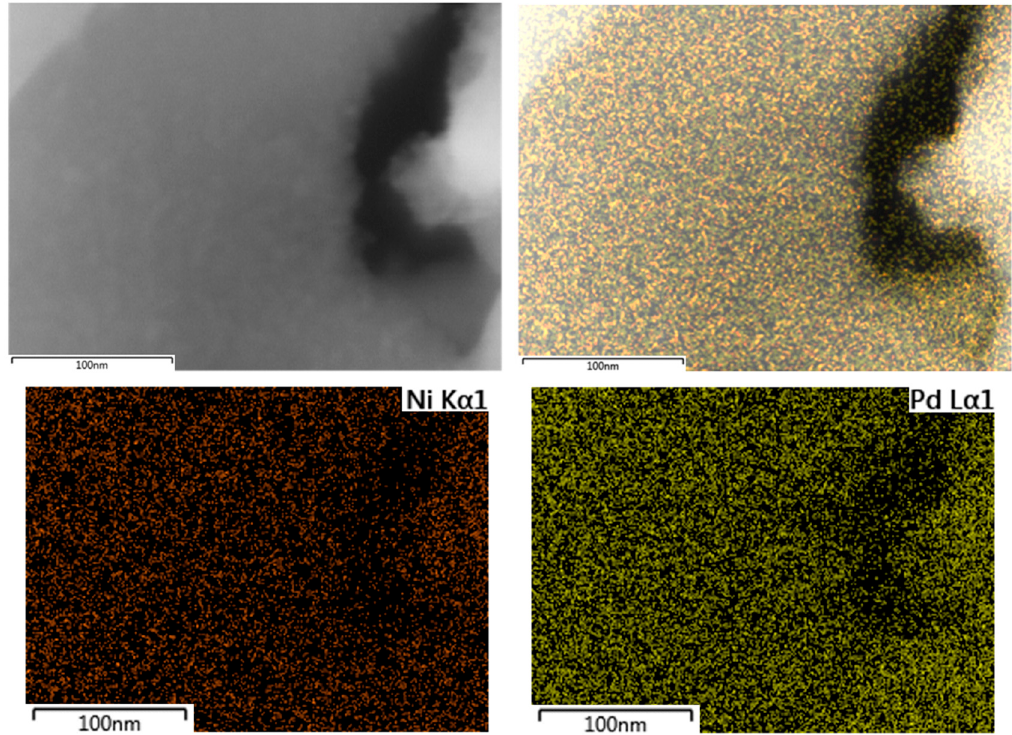
Figure 10. SEM image ( top left ), SEM image with overlay of the palladium and nickel mappings ( top right ), nickel K α 1 EDX mapping ( bottom left ) and palladium L α 1 EDX mapping ( bottom right ) of the PdNi-Ce-LDH-200 catalyst.